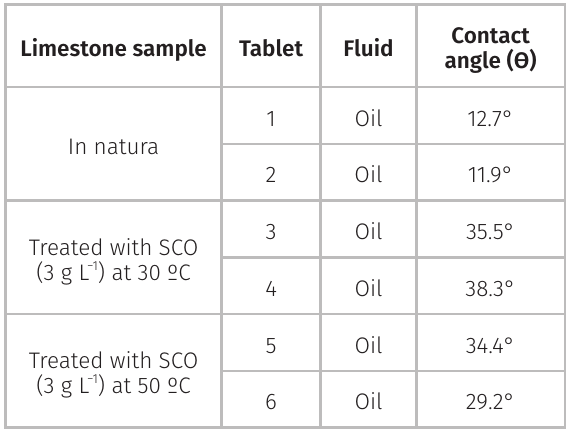
Table V. Zeta potential data for the solutions on limestone.